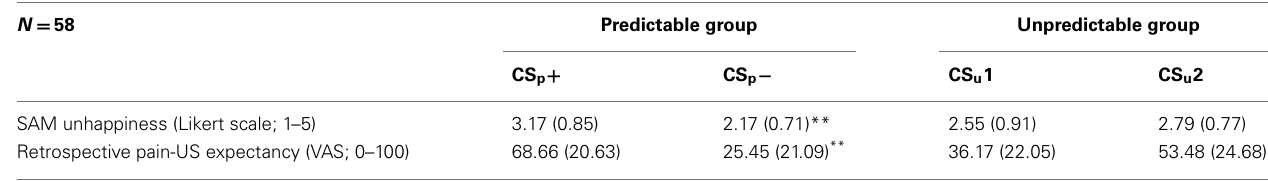
Table 3 | Manipulation check measures: mean SAM unhappiness ratings and retrospective pain-US expectancy ratings (and SD) for the CS p + and CS p − in the predictable group and the CS u 1 and CS u 2 in the unpredictable